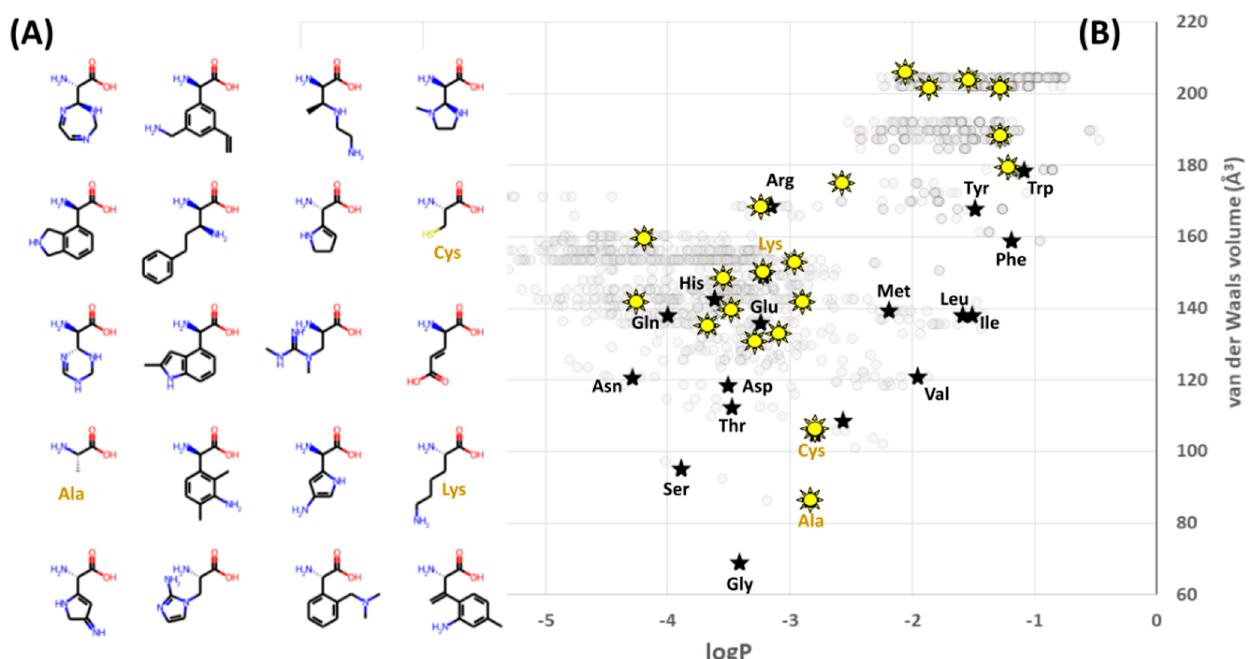
Figure 5. The series of publications reporting unusual features of physicochemistry for the standard amino acid alphabet may be viewed usefully as a series of flawed models attempting to anScheme 46. the model grows more complex at each step, but only in specific, targeted attempts to address these flaws as they come to light. Each step reveals weaknesses in the assumptions thus far, stimulating subsequent steps in a process that refines the model by introducing statistical com- plexity only as needed.